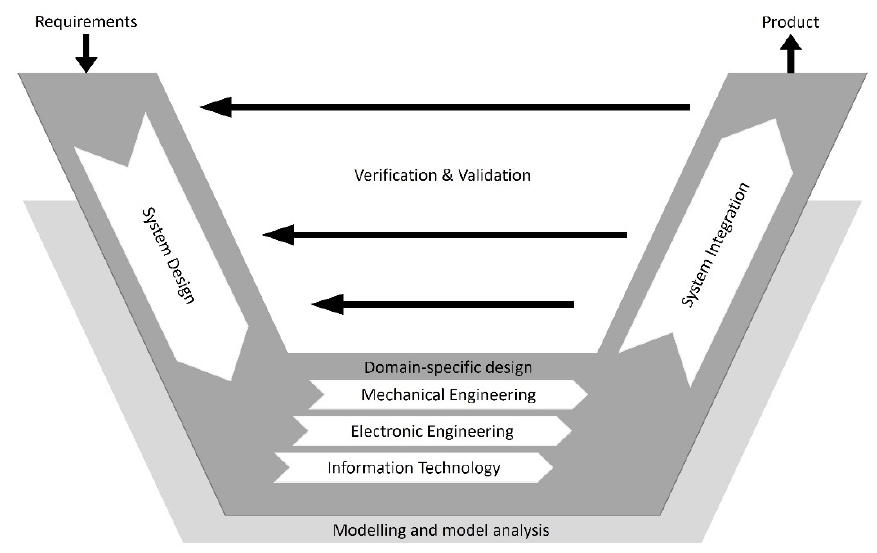
Figure 5. V-shaped product development cycle—based on VDI 2206 [28].